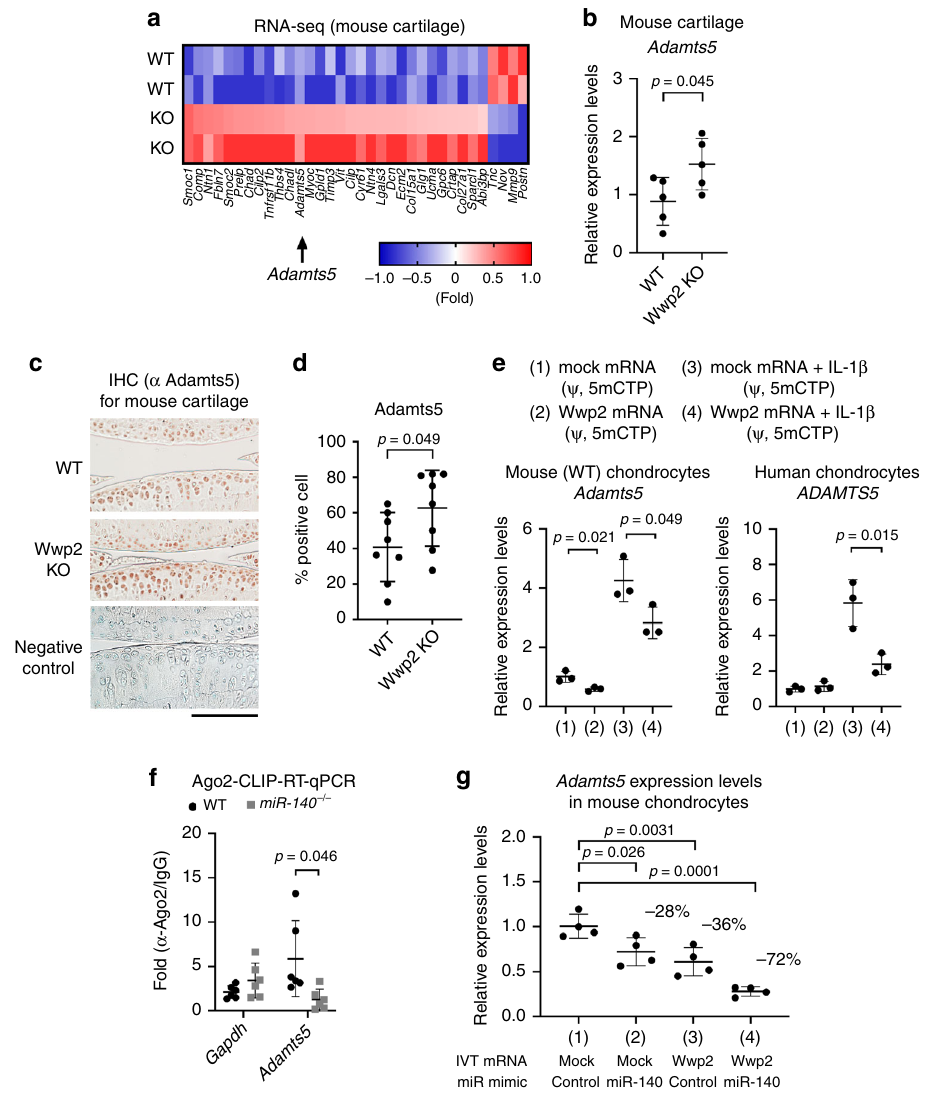
Fig. 3 Wwp2 regulates Adamts5 expression in articular cartilage. a RNA-seq analyses of 2-month-old articular cartilage comparing WT and Wwp2 KO mice. Each samples were isolated from three individual mice. After normalization, Genes with count values ≥ 2000 and a change ≥ 1.5-log2fold were extracted and used for analysis. A heat map showing proteinaceous extracellular matrix related genes, classi fi ed by DAVID analysis. b RT-qPCR for 2- month-old mouse articular cartilage ( n = 5, Student ’ s t test, normalized with Gapdh ). c , d IHC staining of Adamts5 for mouse articular cartilage (6-month- old). c Representative images. Adamts5 was stained with AEC (red). Negative control was stained using rabbit control IgG. d Adamts5 positive cell rate ( n = 8, Student ’ s t test). e Wwp2 overexpression experiments using in vitro transcribed (IVT) mRNA ( ψ , 5mCTP) with or without IL-1 β (10 ng/mL, 17 h) for mouse and human chondrocytes, whose Adamts5 and ADAMTS5 expression levels were analyzed by RT-qPCR ( n = 3, Student ’ s t test, normalized with Gapdh and GAPDH , respectively). f Ago2-crosslinking immunoprecipitation (CLIP) analyses of primary chondrocytes to detect Ago2-binding mRNAs, compared between WT and miR-140 -/- mice ( n = 3, Welch ’ s t test). The primers were designed for the 3 ′ untranslated region of Adamts5 gene and a coding region of Gapdh . g Double overexpression experiments using IVT Wwp2 mRNA ( ψ , 5mCTP) and miR-140 mimic in mouse chondrocytes. RT-qPCR for Adamts5 expression levels ( n = 4, Dunnett test compared with WT and DKO, respectively, normalized with Gapdh ). Black scale bar = 1 mm. Source data are provided as a Source Data fi le. Data are presented as the mean ±